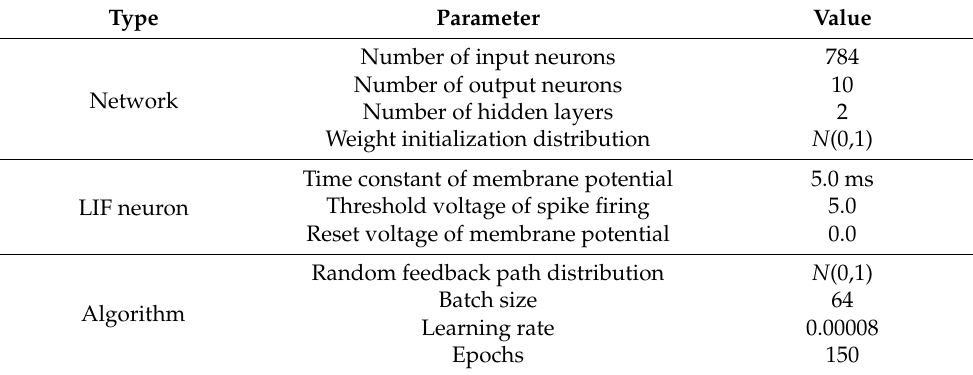
Figure 3. Target spike train generation process using image labels.